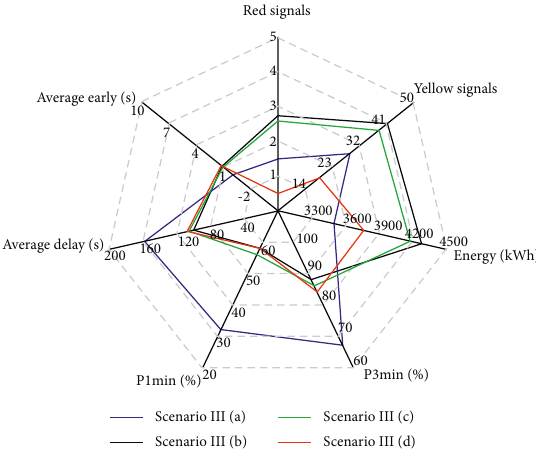
Figure 8: Results of Scenario